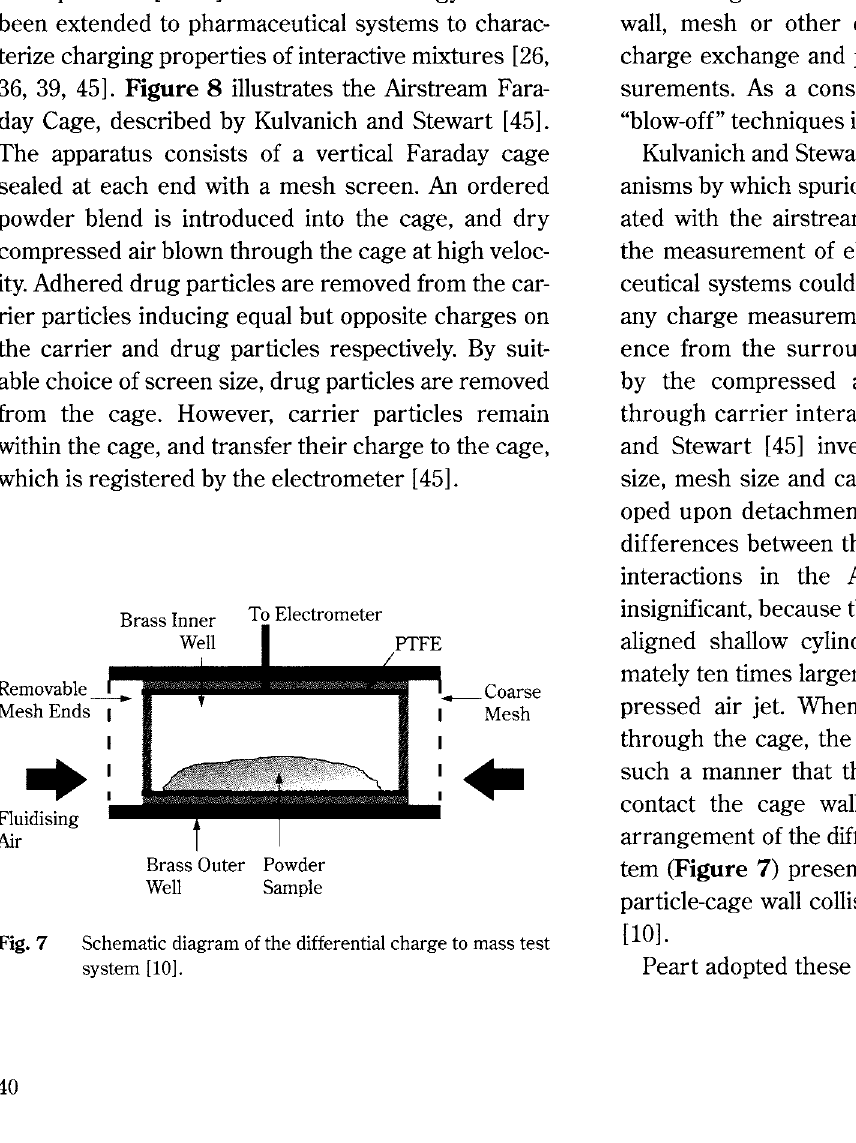
Schematic diagram of the differential charge to mass test system [10].